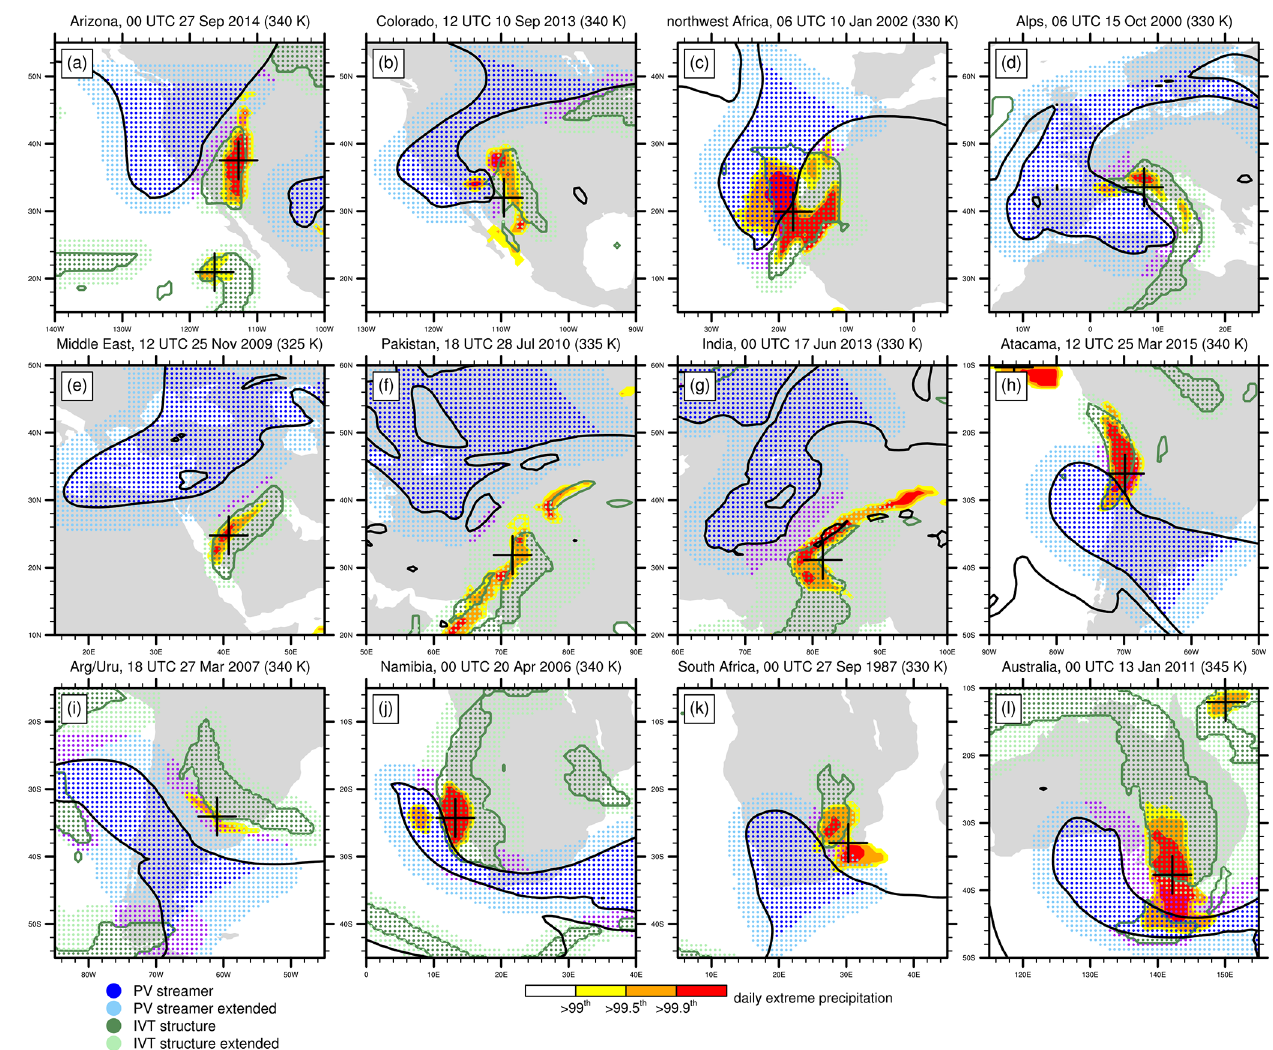
Figure 4. Illustrative cases of extreme precipitation and flooding accompanied by stratospheric PV streamers and IVT structures in (a) Ari- zona, USA, 00:00UTC on 27 September 2014; (b) Colorado, USA, 12:00UTC on 10 September 2013; (c) northwestern Africa, 06:00UTC on 10 January 2002; (d) the Alpine region, 06:00UTC on 15 October 2000; (e) the Middle East, Jeddah, 12:00UTC on 25 November 2009; (f) Pakistan, 18:00UTC on 28 July 2010; (g) India, 00:00UTC on 17 June 2013; (h) the Atacama Desert in Chile, 12:00UTC on 25 March 2015; (i) Argentina and Uruguay, 18:00UTC on 28 March 2007; (j) Namibia, 00:00UTC on 20 April 2006; (k) South Africa, 00:00UTC on 27 September 1987; and (l) Australia, 00:00UTC on 13 January 2011. All meteorological variables and identified objects correspond to those as in Fig. 3b with the exception of extreme precipitation, for which only the objects instead of all percentile-exceeding grid points are